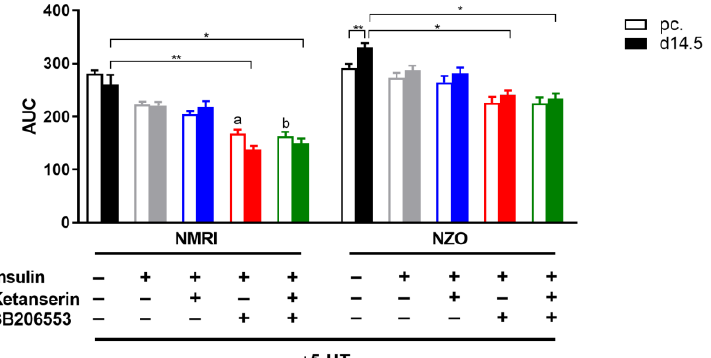
Figure 6. Effects of 5-HT on hepatic glucose production are mediated by 5-HTR2B/C. Area under the curve (AUC) for glucose production in cultured primary hepatocytes of NMRI and NZO mice using the trapezoidal rule at time points preconceptional (open bars) and d14.5 of gestation (filled bars) without or after initial insulin stimulus and incubation with 5-HT or co-incubation with HTR antagonists. Co-incubation with Ketanserin (HTR2A antagonist) and SB206553 (HTR2B/C antagonist). Data are presented as means ± SEM ( n = 5 animals per group). * p < 0.05, ** p < 0.01, NMRI pc. w/o I vs. NMRI pc. +I+SB206553: a p < 0.05, NMRI pc. w/o I vs. NMRI pc. +I+Ketanserin+SB206553: b